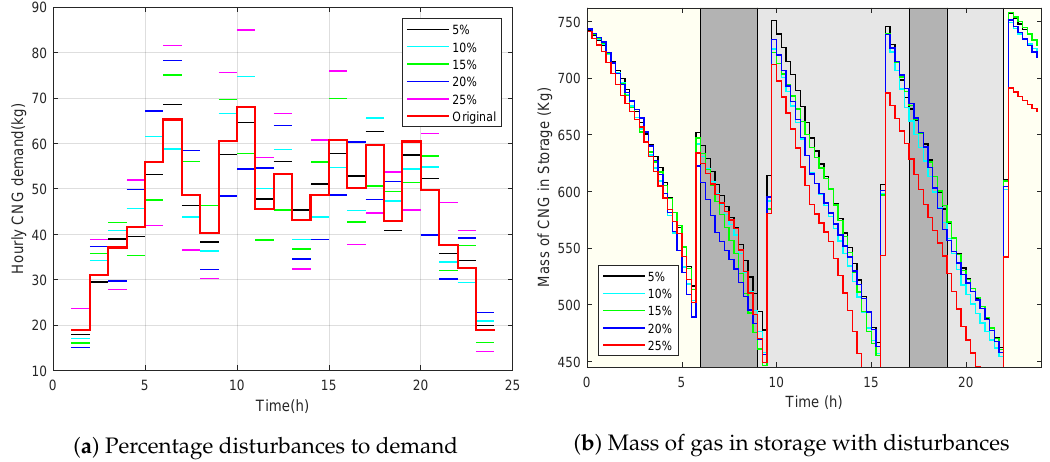
Figure 11. System performance under random gas demand disturbances.